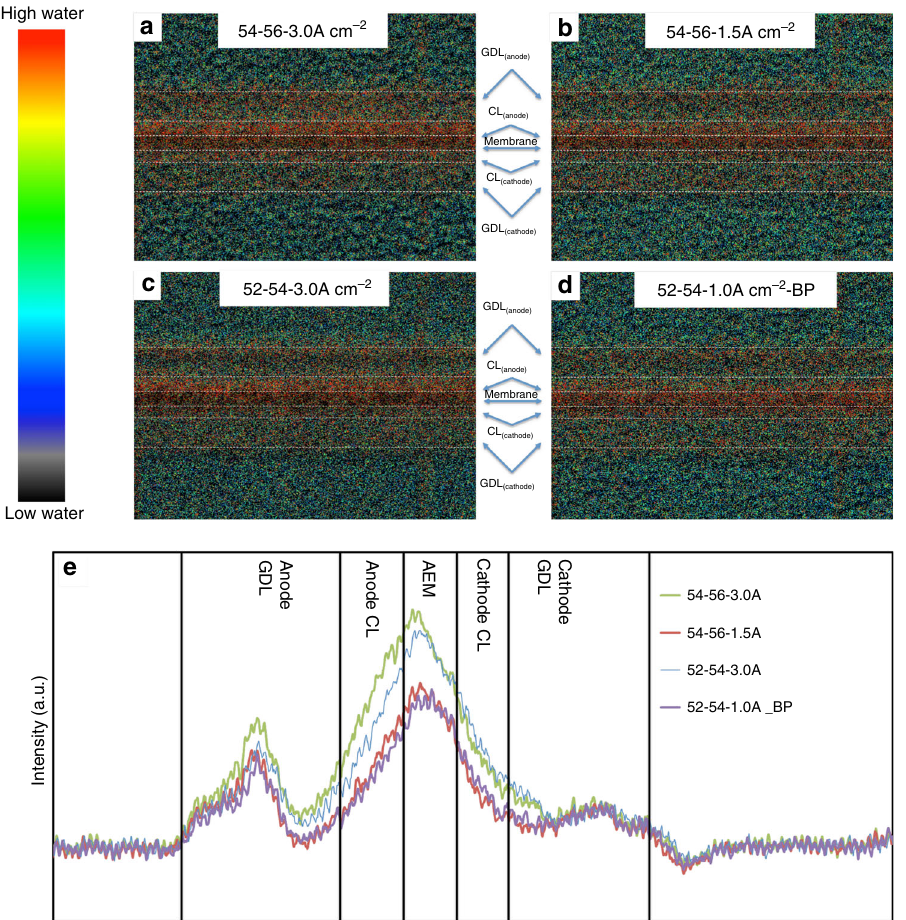
Fig. 4 Water distribution at different operating conditions. Operando in-plane high-resolution neutron radiographic images of water in the gas diffusion layers, catalyst layers, and the radiation-grafted ETFE-BTMA AEM in operating at: ( a ) 3.0Acm − 2 with anode/cathode dew points of 54/56°C; ( b ) 1.5Acm − 2 with anode/cathode dew points of 54/56°C; ( c ) 3.0Acm − 2 with anode/cathode dew points of 52/54°C; ( d ) 1.0Acm − 2 with anode/cathode dew points of 52/54°C and 140kPa back pressure; ( e ) qualitative through-plane water distribution plots extracted from high-resolution images. The intensity indicates the water thickness inside the MEA. The operando cells used in the neutron beam (1.2cm 2 active area) were constructed with a 0.70mg PtRu cm − 2 PtRu/C anode, a Pt/C cathode at 0.60mg Pt cm − 2 , and a radiation-grafted ETFE-based AEI powder ionomer and ETFE-BTMA AEM (hydrated thickness = 50 μ m). The cell temperatures were maintained at 60°C. The full length of images are shown in Supplementary Fig.